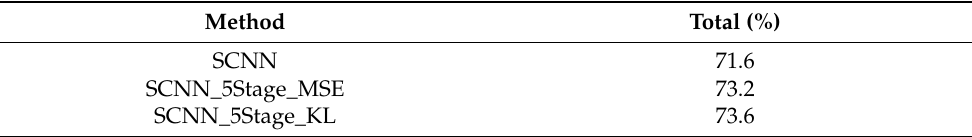
Table 5. Influence of different distillation loss functions on lane line detection performance